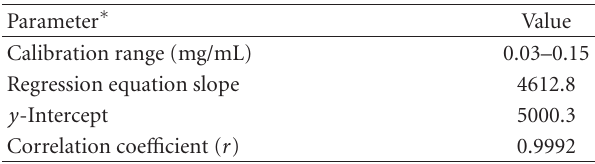
Table 1: Linear regression data of the HPLC method for the determination of hederacoside C in Ivy-Thyme cough syrup.